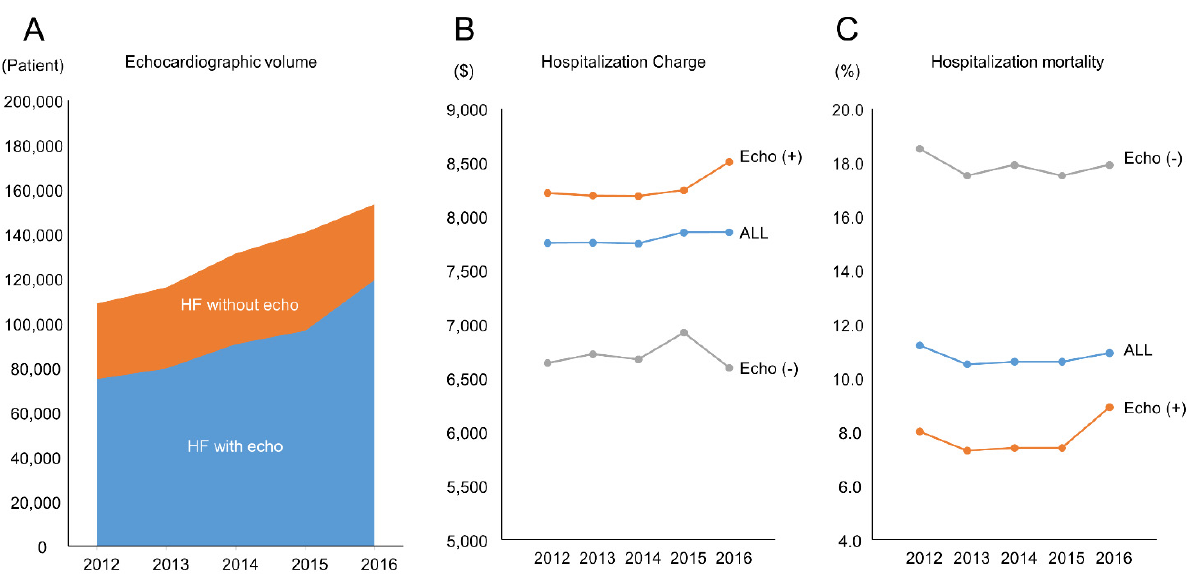
Figure 2. Trends in echocardiography use between 2012 and 2016. ( A ) Echocardiographic volume; ( B ) Hospitalization; ( C ) Charge; ( C ) Hospitalization mortality; HF, heart failure; $, US dollar.